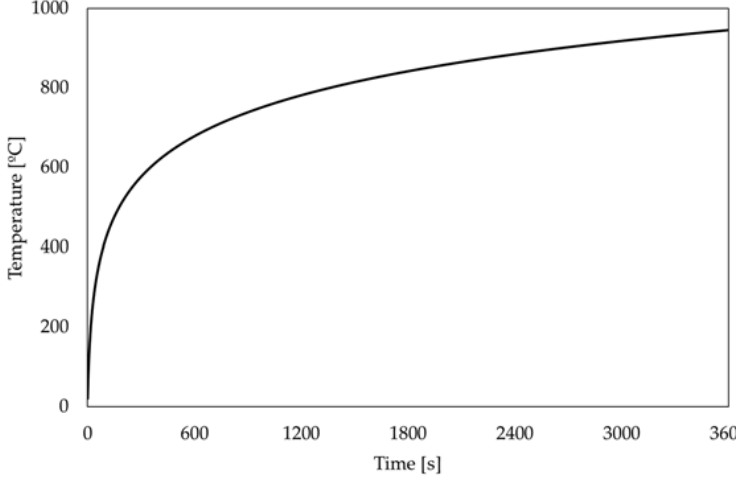
Figure 6. Nominal temperature–time curve ISO 834.